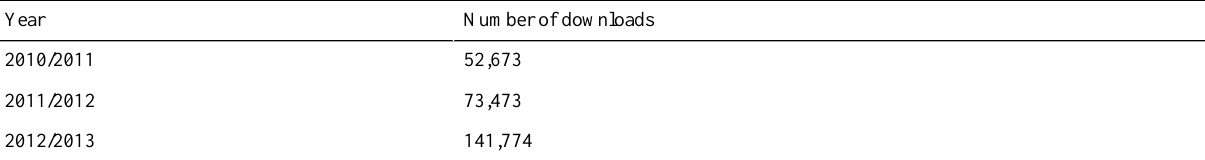
Table 4. Total number of downloaded documents from the e-Bug website for each academic year. Number of